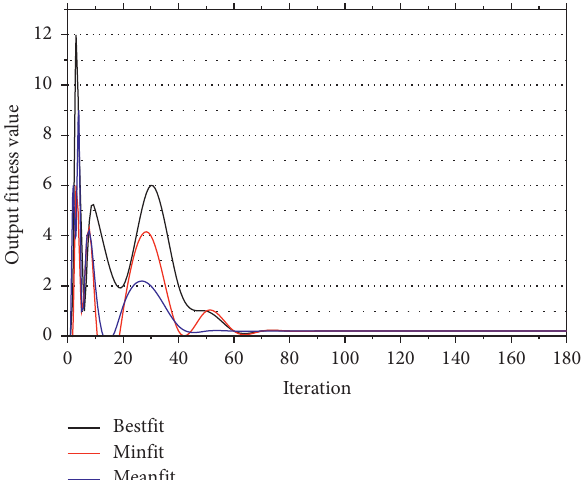
Figure 3: Optimal individual fitness of P-algorithm.